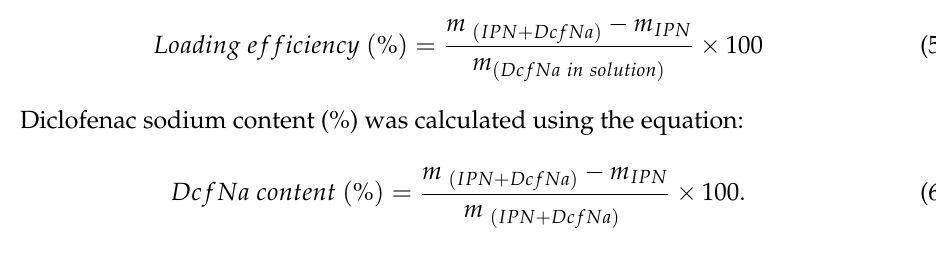
Figure S5. Micrographs of PDMAEMA/PAAm IPNs with different composition ( ϕ PDMAEMA) at magnification × 30,000. Figure S6. Micrographs of PDMAEMA/PAAm IPNs with different composition ( ϕ PDMAEMA) at magnification × 60,000. Figure S7. X-ray diagrams of the four PDMAEMA/PAAm IPNs, as well as of the single PAAm network. Figure S8. TGA (green line) and DTA (blue line) of PAAm single network. Figure S9. TGA of the four PAAm/PDMAEMA IPNs. The TGA curves for the single PAAm and PDMAEMA networks are also provided. Figure S10. TGA (green line) and DTA (blue line) of IPN 4 ( ϕ PDMAEMA =